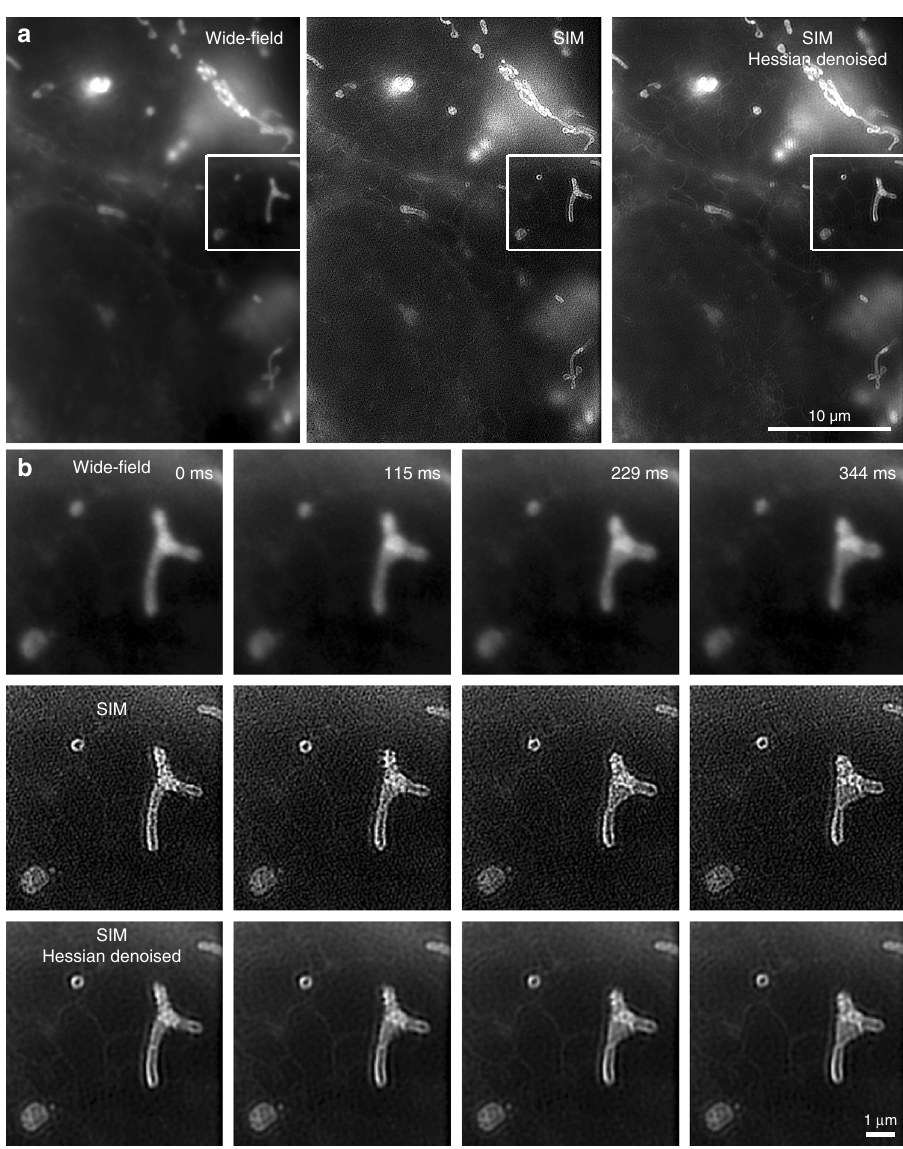
Fig. 5 Demonstration of the system in use for live-cell imaging of mitochondrial dynamics. Single-color imaging of U2OS cells with 5 ms raw frame exposure time (see Fig. 2b), with overview ( a ) and time series of cut-out ( b ). The dynamics could be observed in real time and super-resolution by the system operator. The microscope hardware could easily provide higher speeds and continuous data acquisition, however, current dyes are limited in both brightness and photo-stability. Nonetheless, short exposure times are still very helpful in time-lapsed acquisition, as they suppress motion blur